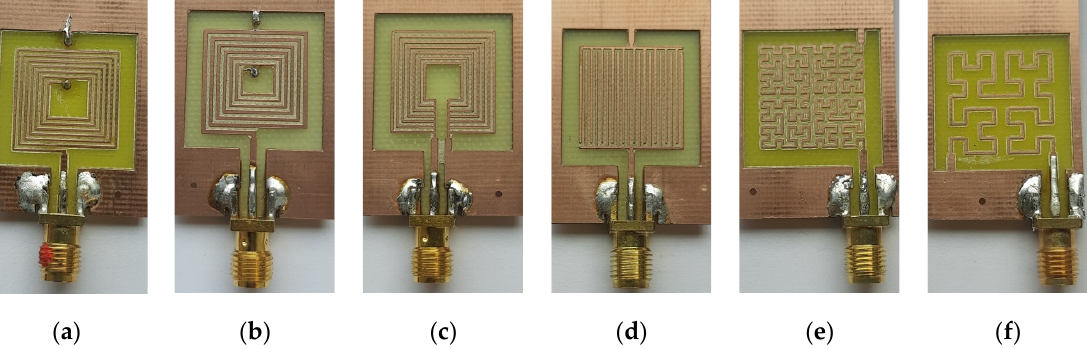
Figure 5. Different inductor topologies patterned on PCB interfaced via SMA connector: ( a ) spiral, ( b ) tapered, ( c ) non-spiral, ( d ) meander, ( e ) fourth-order fractal, and ( f ) third-order fractal.